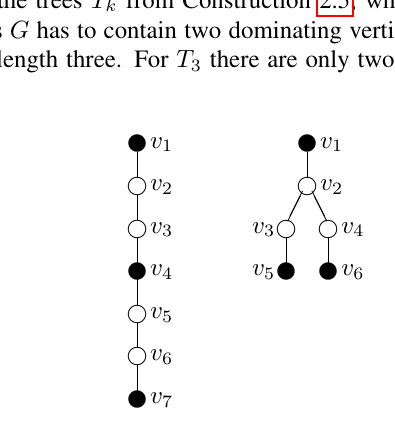
Fig. 11: The two possible trees T 3 for γ = 3